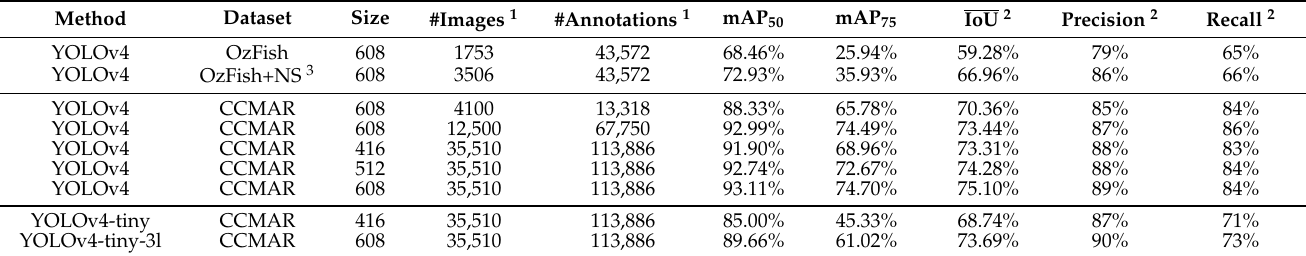
Table 1. Model training parameters and results using the YOLOv4